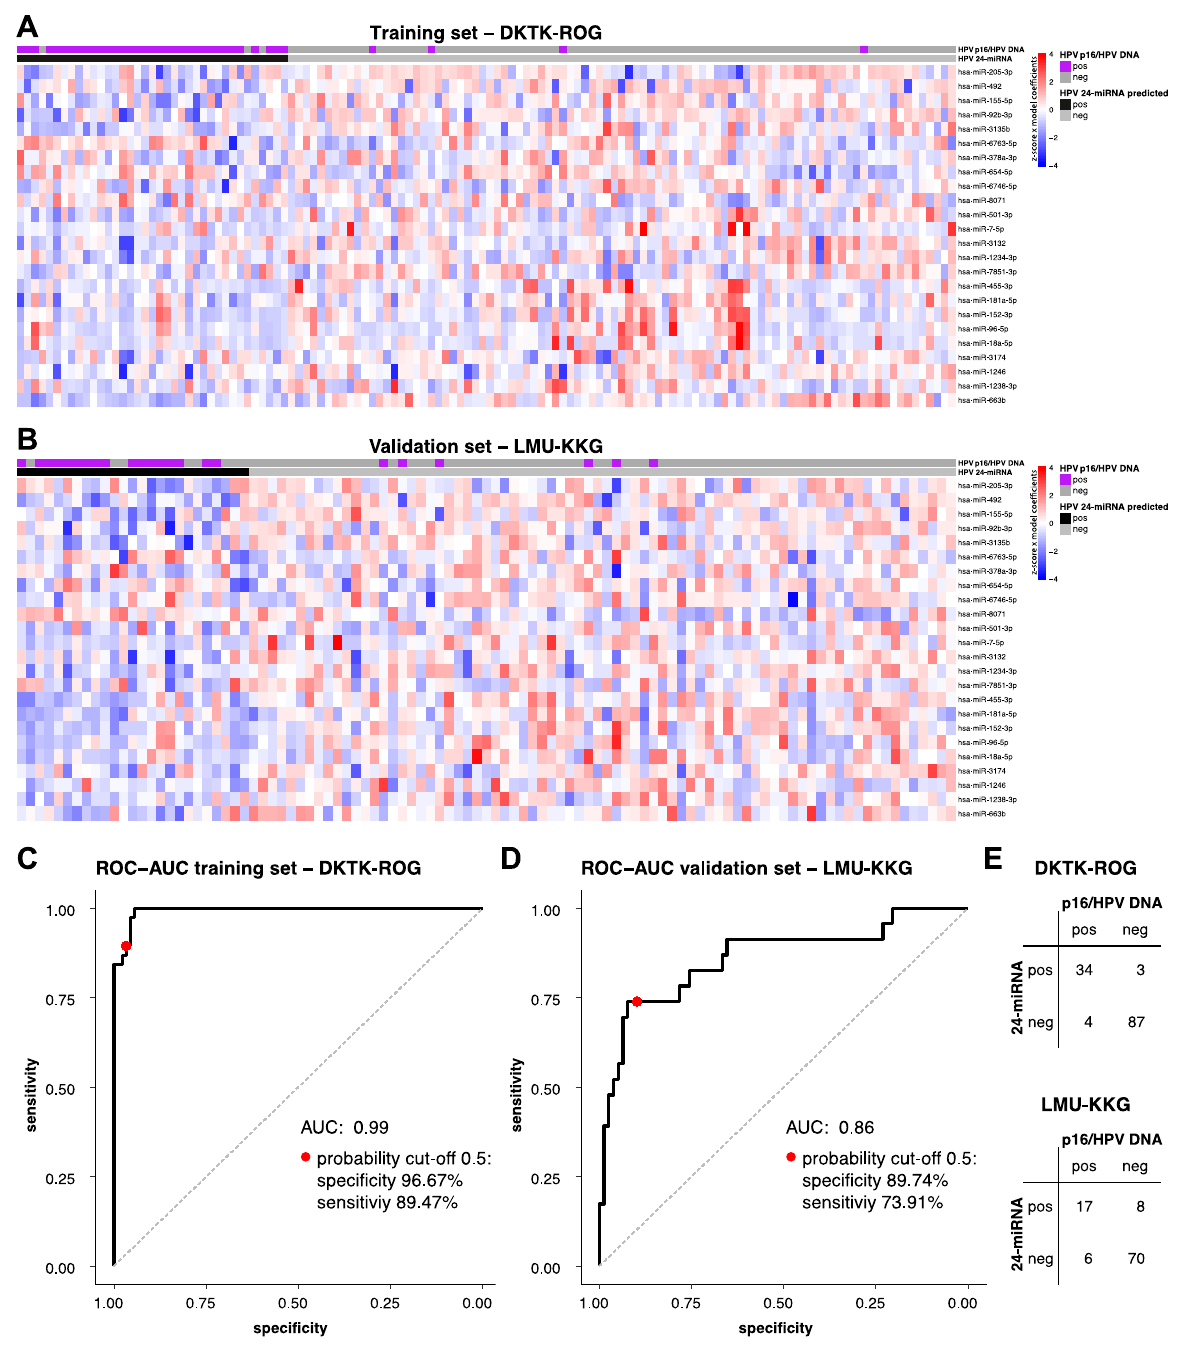
Figure 1. HPV-status predicted by the 24-miRNA signature. Heat map colours indicate scaled miRNA log2 expression values multiplied by the model coefficients from low (blue) to high (red) on a scale of − 4 to 4 for each of the 24 signature miRNAs ( A ) in the training DKTK-ROG and ( B ) in the LMU-KKG validation set. HPV-status according to p16/HPV DNA and the 24-miRNA signature is indicated on a case-by-case basis. Performance of the 24-miRNA signature: sensitivity-derived and specificity-derived ROC-AUC for HPV-status prediction ( C ) in the DKTK-ROG training set and ( D ) in the LMU-KKG validation set. The AUC and the sensitivity and specificity rates at a probability cut-off of 0.5 are given. ( E ) Confusion matrix reporting the number of 24-miRNA signature predicted and p16/HPV DNA-positive and -negative HNSCC cases in the DKTK-ROG (top) and the LMU-KKG set (bottom).